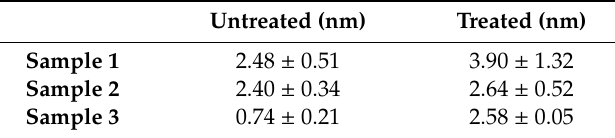
Table 3. Mean surface roughness Sa measured on 1 × 1 µ m area by AFM.